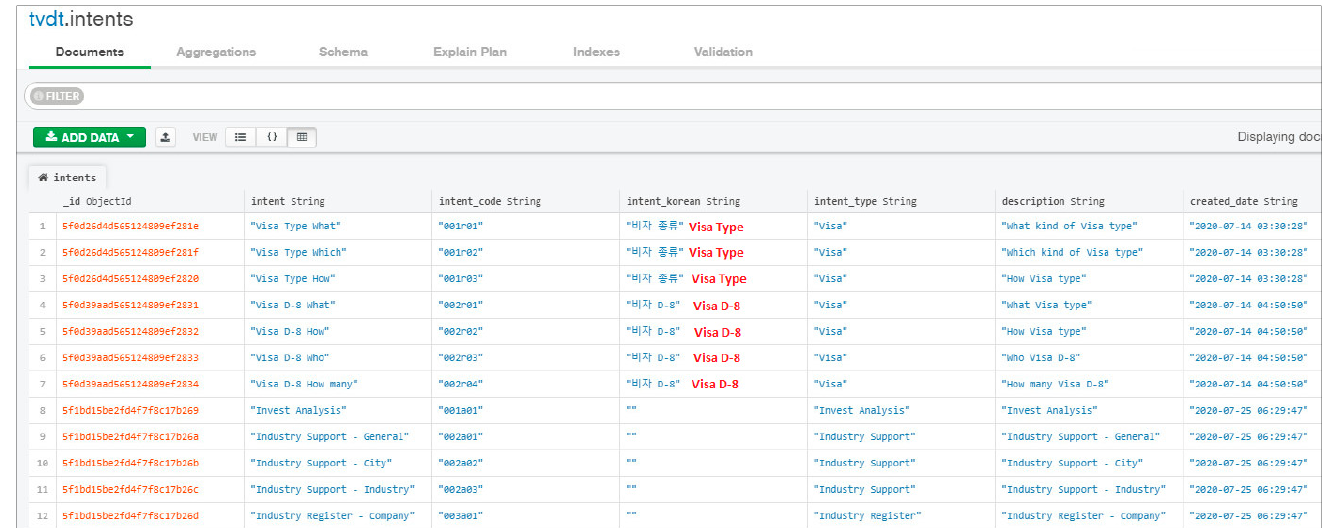
Figure 17. Intents’ dataset stored in MongoDB.